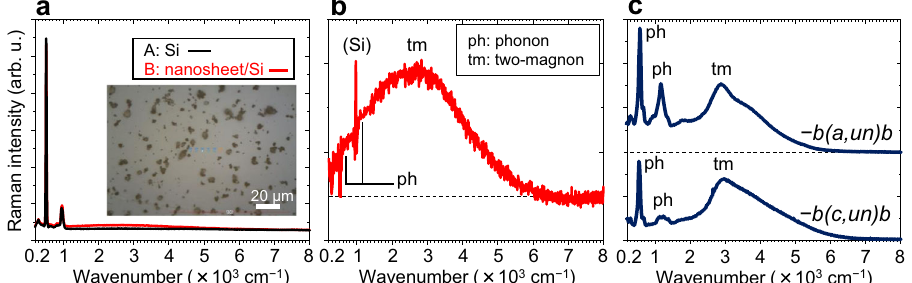
1 2 3 4 5 6 7 8 )0.2 Wavenumber ( 10 3 cm −1 Fig. 4 Raman spectra. The sample was the fi lter residues of polycrystalline LCCO subjected to immersion to NaOH aqueous solution with 5 mol/L concentration and stirring for 6 h. a Spectra of areas, excluding and including the nanosheets in the Si substrate. The inset is the optical microscopy image, where the canter and 5 μ m away points were inspected. Note that the nanosheets are not observed by optical microscopy. b The increase in intensity compared with the two spectra in Fig. 4a. c Raman spectra of the ca plane of the single crystal synthesized by a traveling solvent fl oating zone method 5 (TSFZ; See Methods regarding the synthesis methods). Polarization con fi gurations are indicated by the Porto notation 42 , − b ( a / c , un ) b , i.e. a- or c -axis linearly-polarized lights entered the ca plane toward the − b axis and the backscattered, unpolarized light was imperfections for the chemical reaction proposed later (Eq. (1)) or the conductive Si substrate.